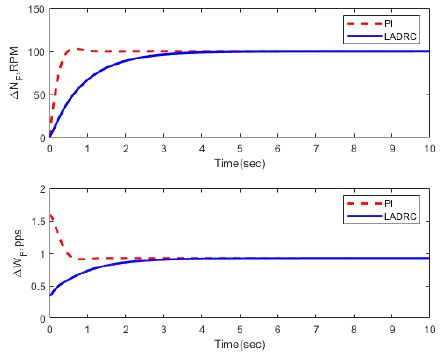
Figure 11. Step response of FC02.